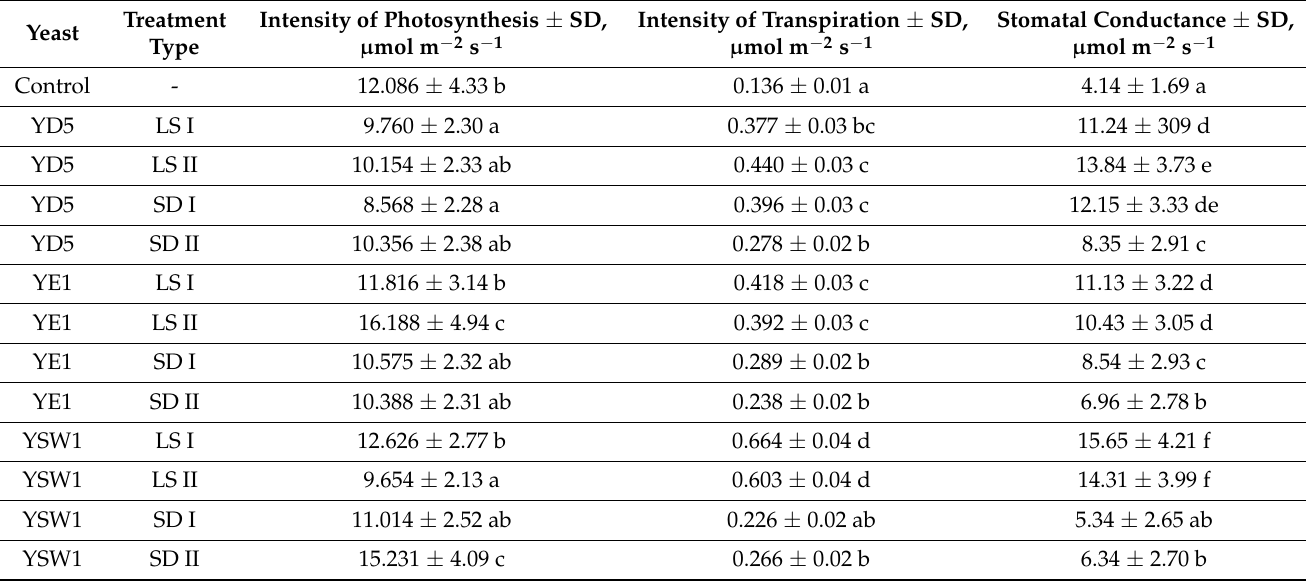
Table 8. Photosynthesis and transpiration rate in experimental tobacco plants: 28th day after first treatment and 14th day after second